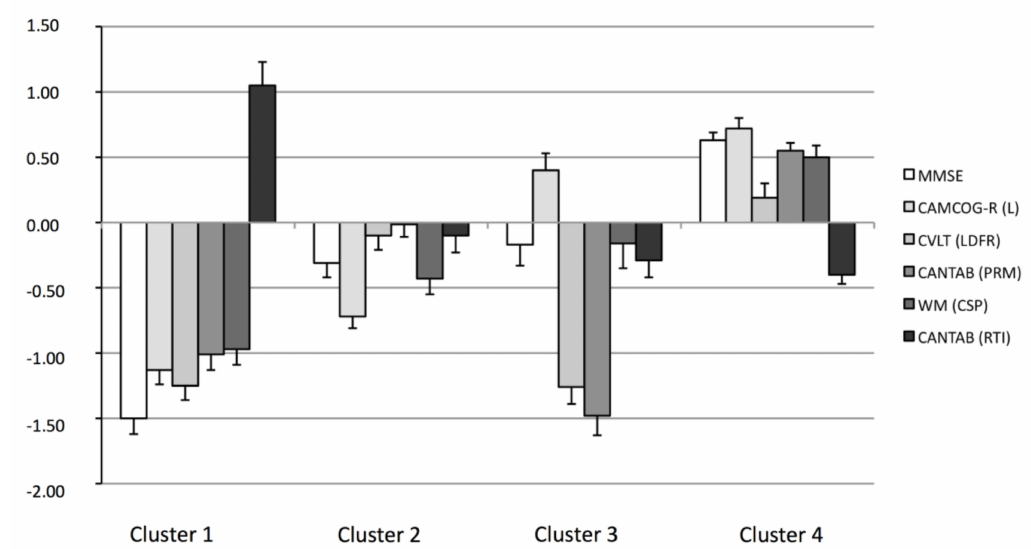
Figure 1. Mean values ( z scores) and standard errors (bars) of the six neuropsychological measures used for the cluster analysis for the four empirical groups (Cluster 1, Cluster 2, Cluster 3 and Cluster 4). MMSE: Mini-Mental State Examination; CAMCOG-R (L): Cambridge Cognitive